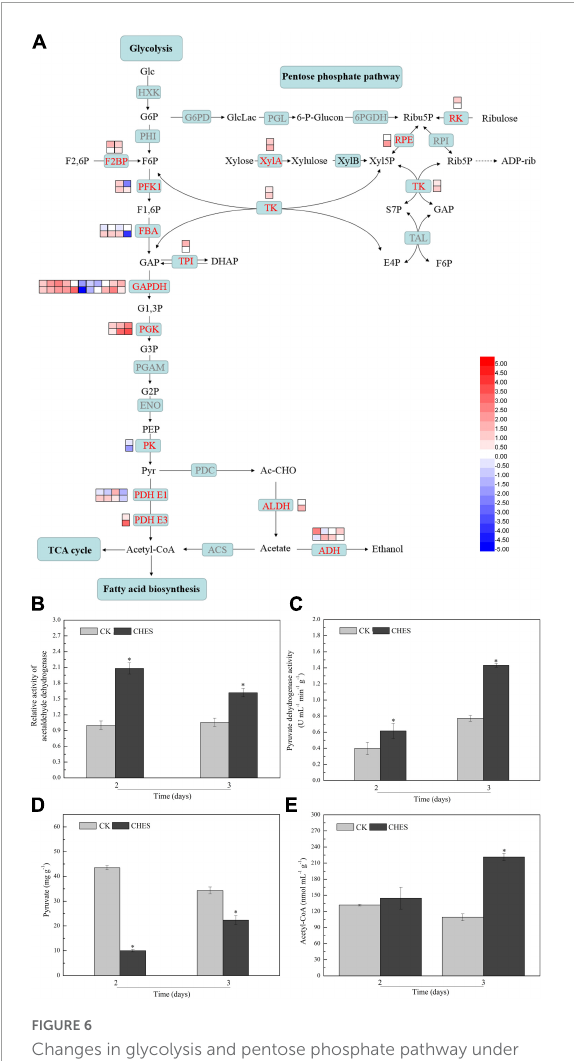
FIGURE6 Changes in glycolysis and pentose phosphate pathway under CHES treatment in P. tricornutum . (A) The expression of gene involved in glycolysis and pentose phosphate pathway were determined by RNA-Seq in 2 and 3 days after culture. The upper and lower panels were determined in 2 and 3 days after culture, respectively. The activity of acetaldehyde dehydrogenase (B) and pyruvate dehydrogenase (C) were determined in 2 and 3 days after culture. The content of pyruvate (D) and acetyl-CoA (E) were determined in 2 and 3 days after culture. Each bar represents three replications. Values represent mean ± SD ( n =